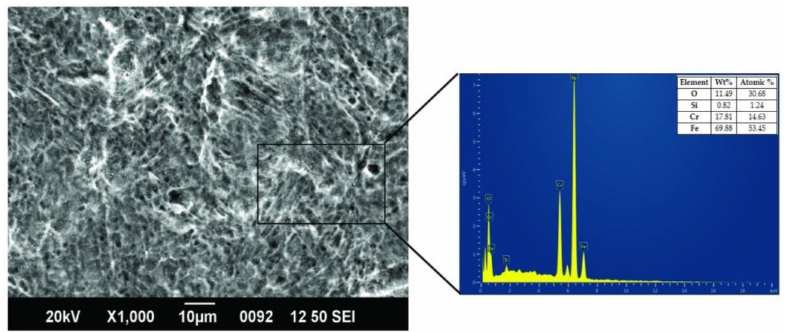
Figure 6. Microstructure and EDAX spectra of Fe 3 O 4 -coated SS